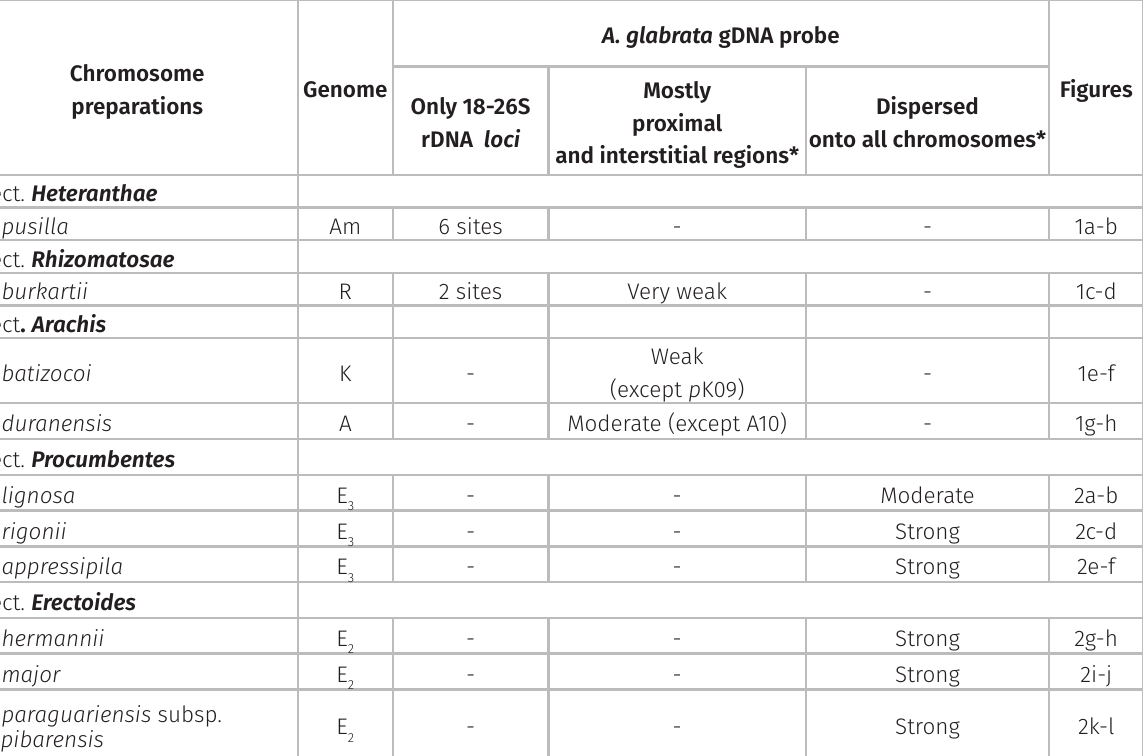
Table III. Summary of the semiquantitative hybridization patterns after single GISH experiments using A. glabrata gDNA as probes onto the chromosomes of different diploid Arachis